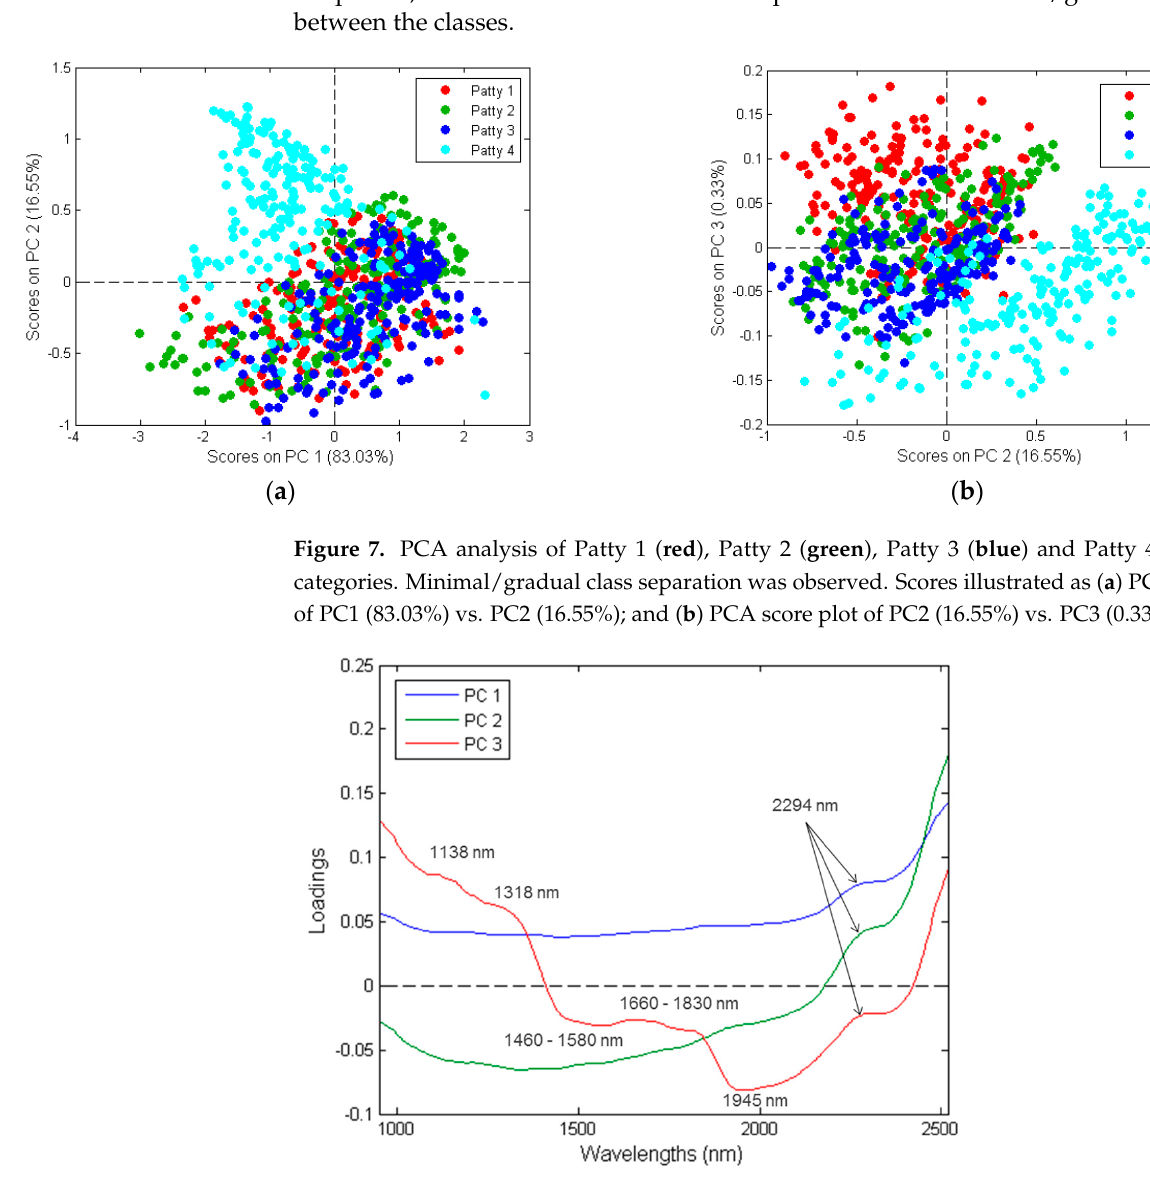
Figure 8. PCA loadings line plot for PC1 ( blue ), PC2 ( green ) and PC3 ( red ) with interpretable bands at 1138, 1318, 1460–1580, 1660–1830, 1945 and 2294